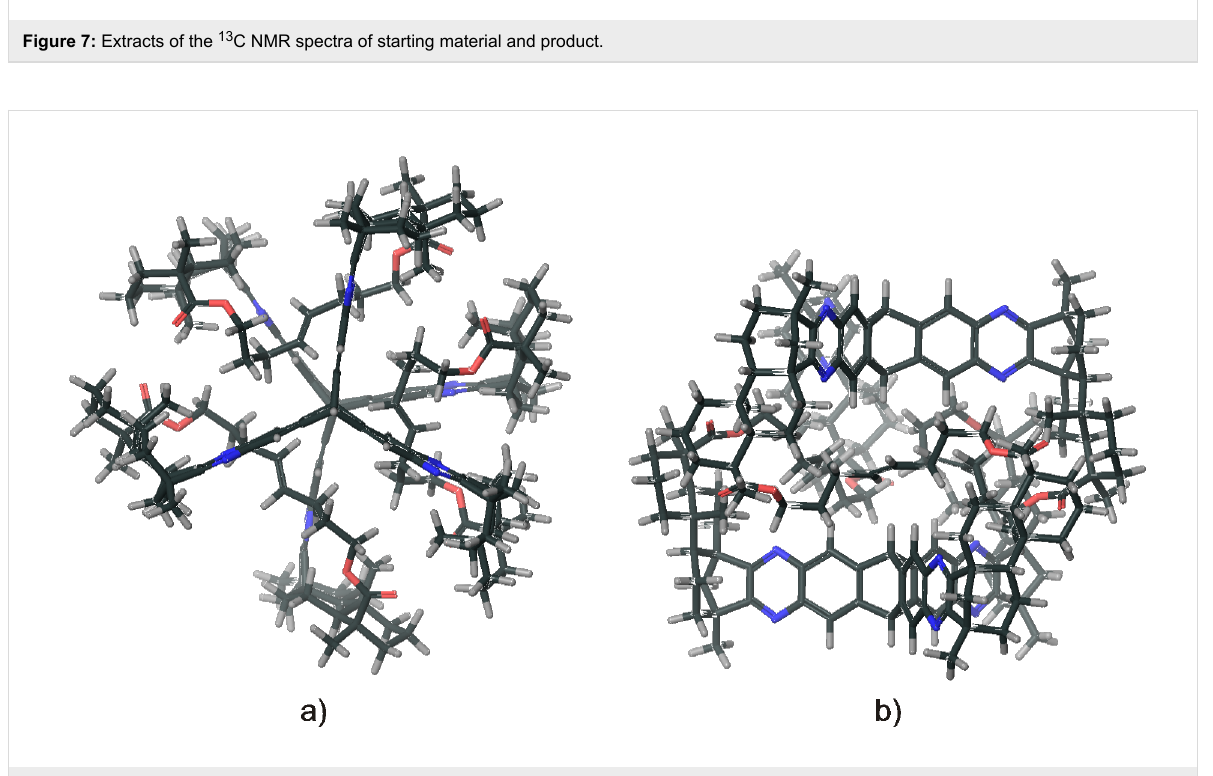
Figure 7: Extracts of the 13 C NMR spectra of starting material and product.